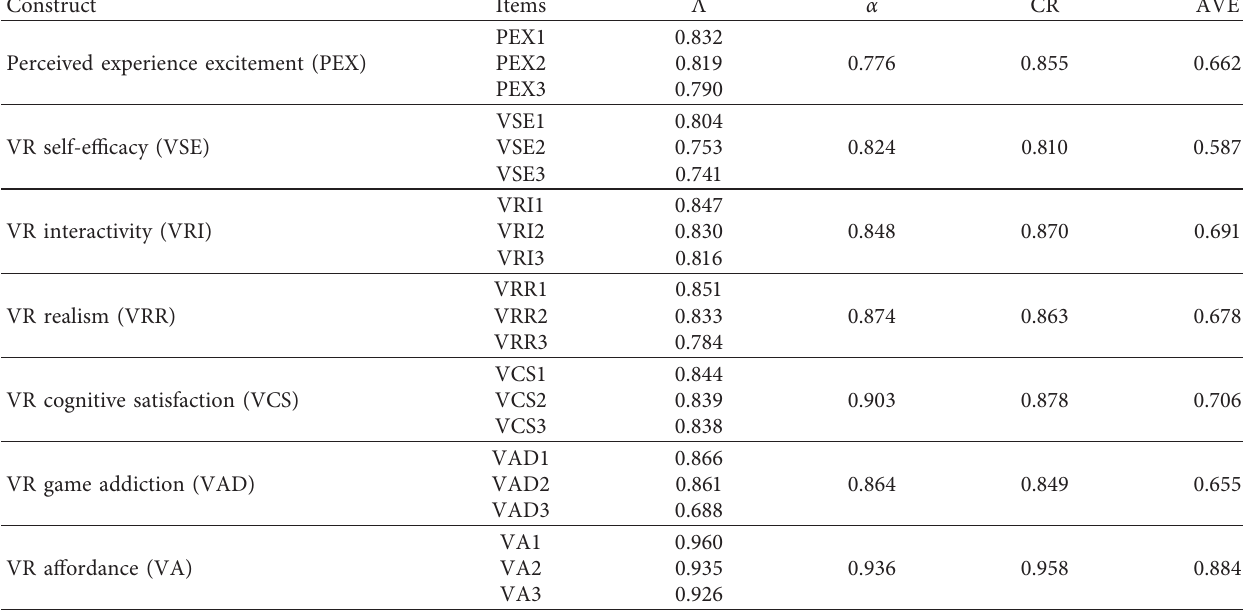
Table 3: Reliability and validity analysis through CFA.